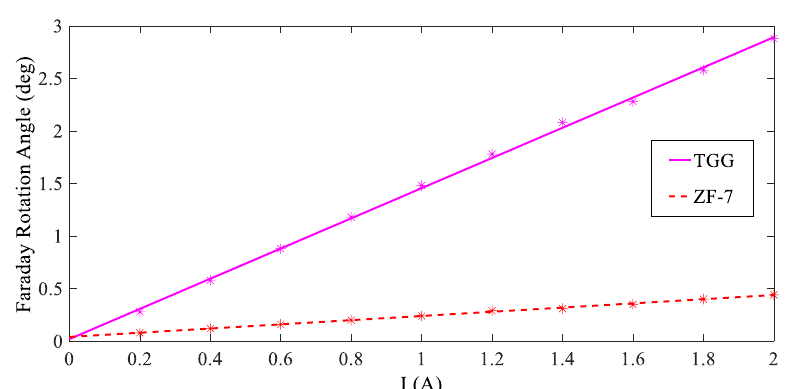
ff erent magnetic fields. TGG, Tb 3 Ga 5 O 12